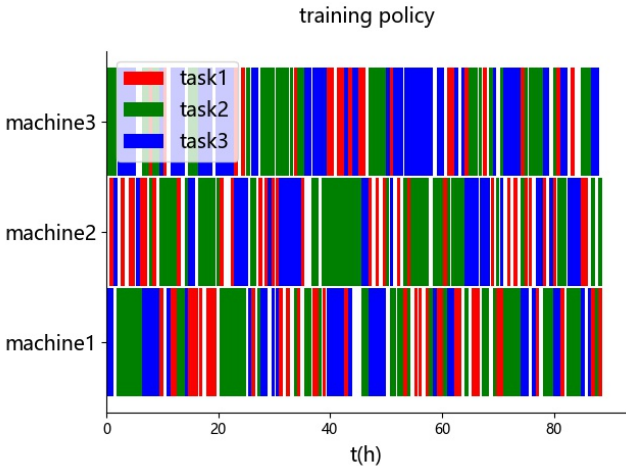
Figure 9. Gantt chart of training end strategy scheduling method. Table 4. Comparison of scheduling results of loading and